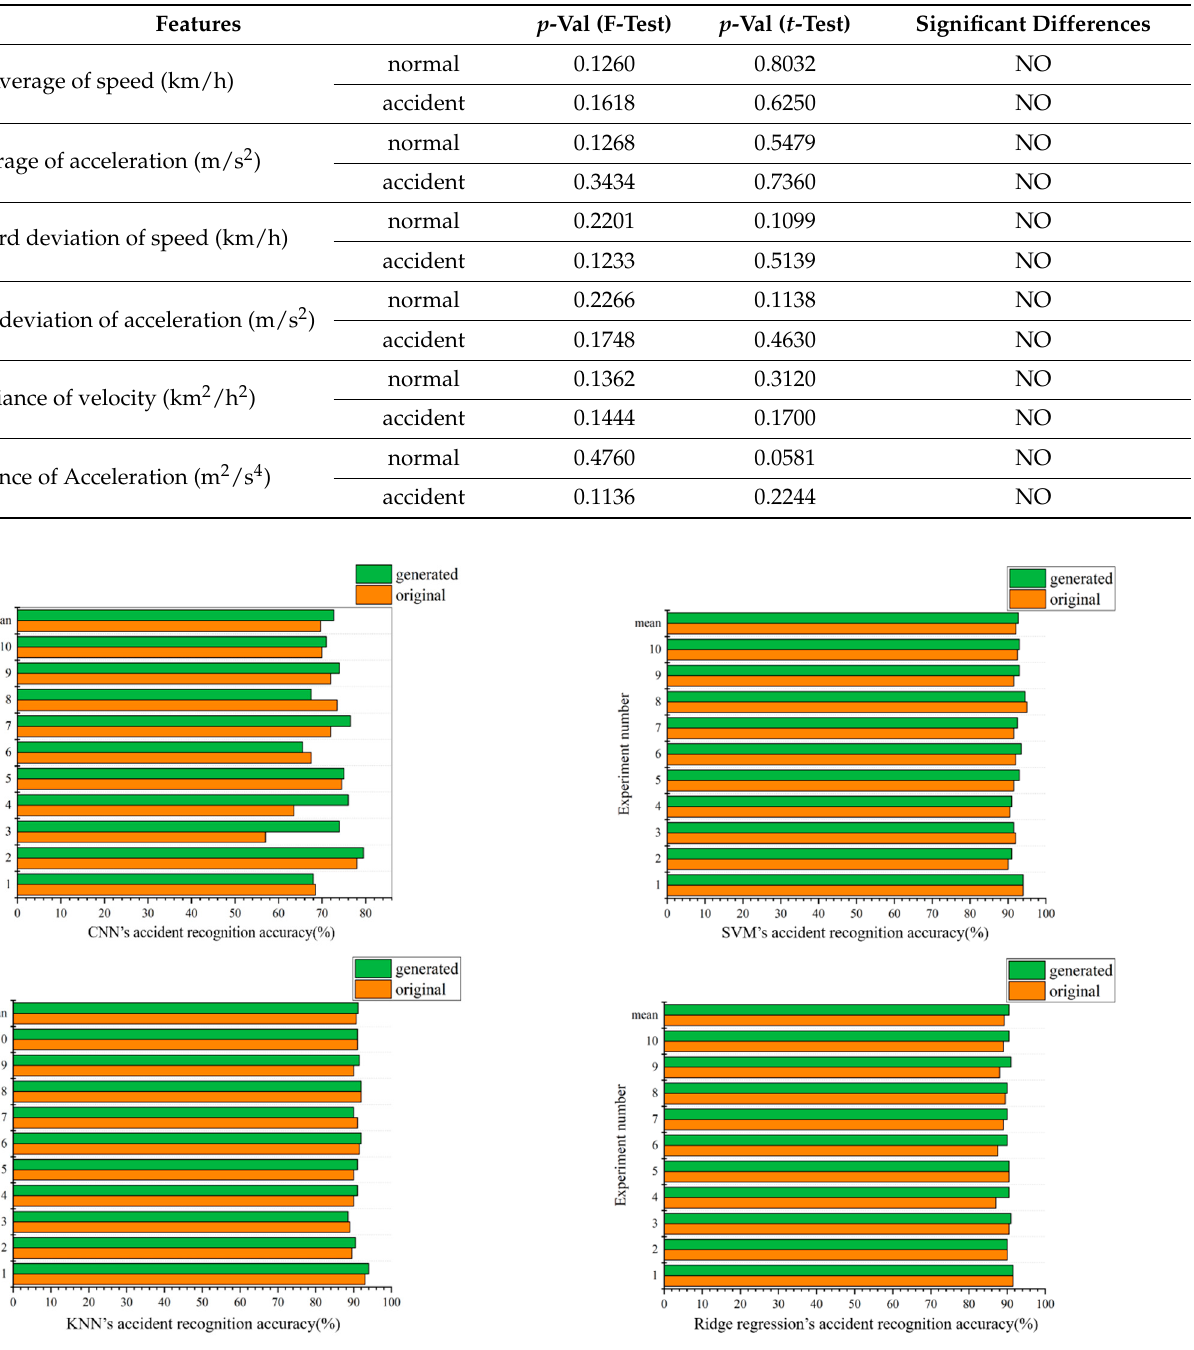
Figure 5. Comparison of accident recognition accuracy of each classifier trained on different datasets. The “generated” in the figure represents the “original + generated” data.